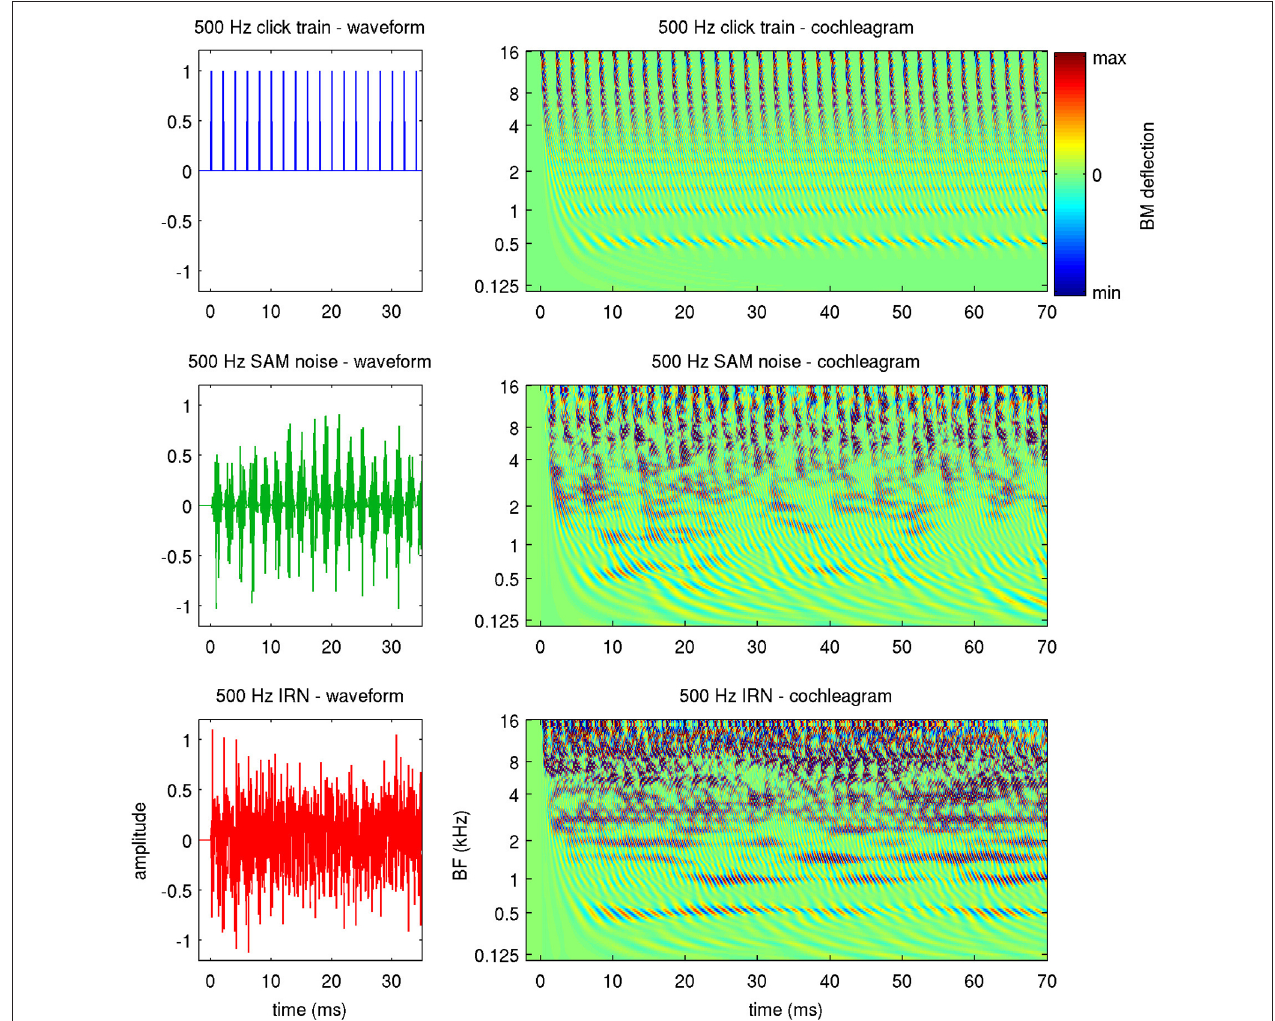
filter bank, and provide an estimate of the basilar membrane (BM) deflection expected along the tonotopic array ( y -axis) as a function of time ( x